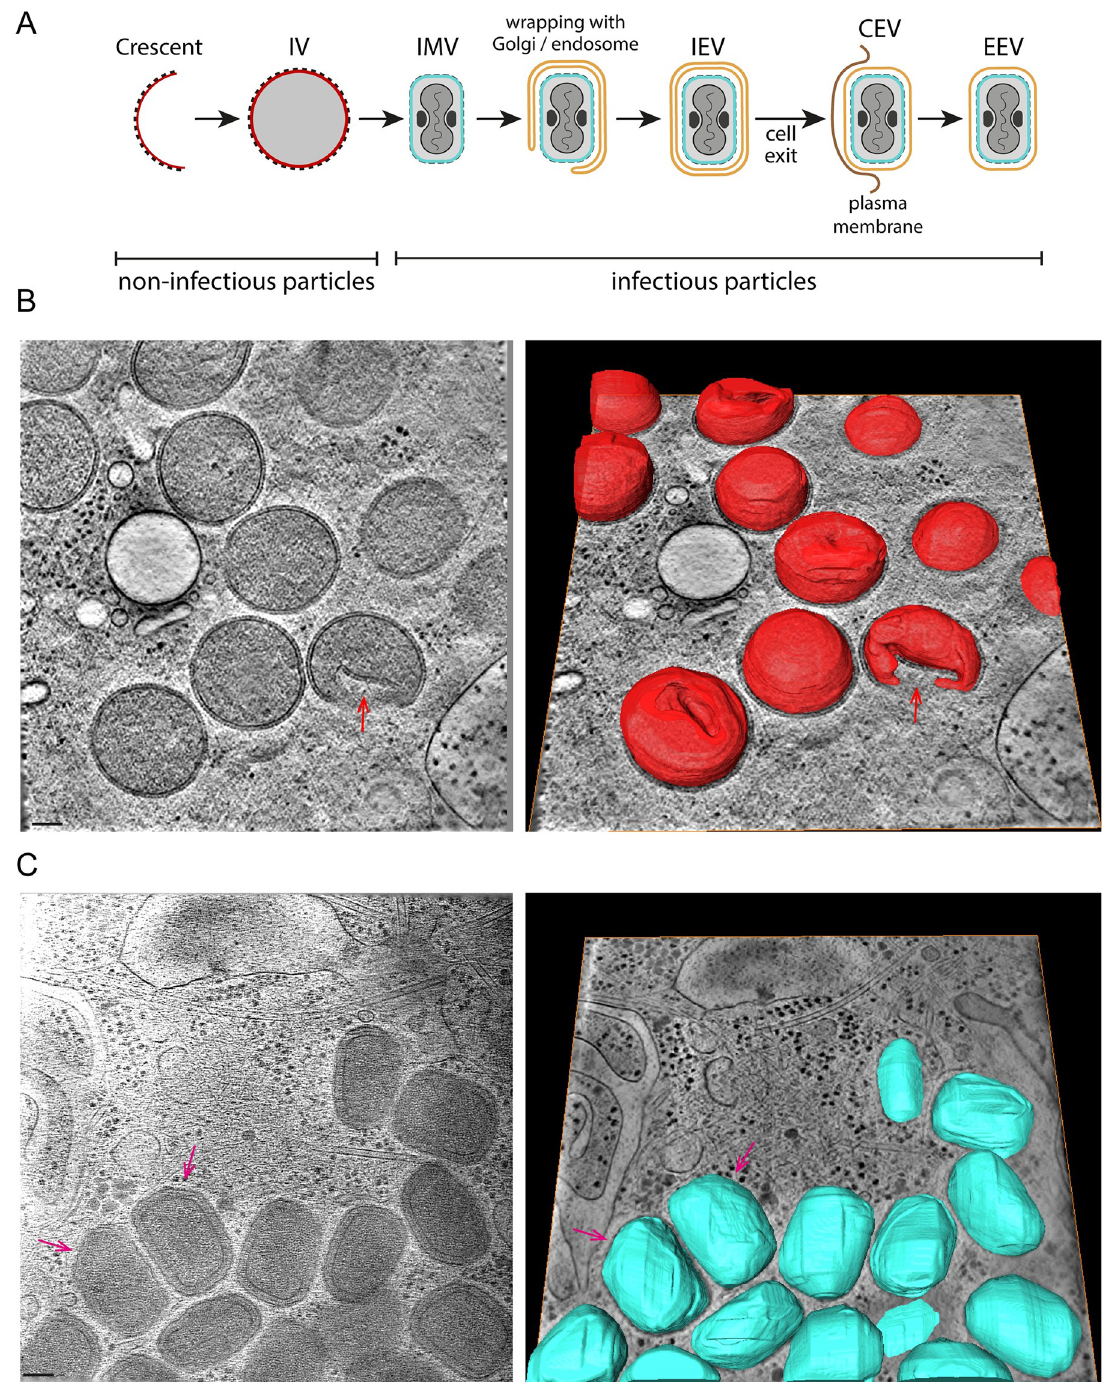
Fig 1. Cryo-ET of vaccinia-infected cells. ( A ) Schematic representation of vaccinia assembly and envelopment. D13-coated membrane crescents close to form a spherical IV (membrane in red), which mature into brick-shaped IMV (membrane in blue) with a viral core that presents 2 concavities, occupied by 2 lateral bodies (black). IMV can be enveloped by a Golgi cisterna or endosomal compartment (orange), resulting in the formation of triple membraned IEV, which can fuse with the plasma membrane to liberate EEV, which are called CEV if they remain attached to the cell surface. ( B ) Left: Central section of a tomogram showing fully formed IV. The red arrow points at an IV with a lateral invagination, which is detected in 8 out of the 11 IV in the tomogram. Invaginations in other IV can be seen in the 3D-segmented model of the membrane of the same tomogram (right) (see S1 Movie). The sample thickness range was 310–360 nm. ( C ) Tomogram middle view (left) and its corresponding segmentation (right) of IMV (see S2 Movie). A “cut corner” (magenta arrows) is